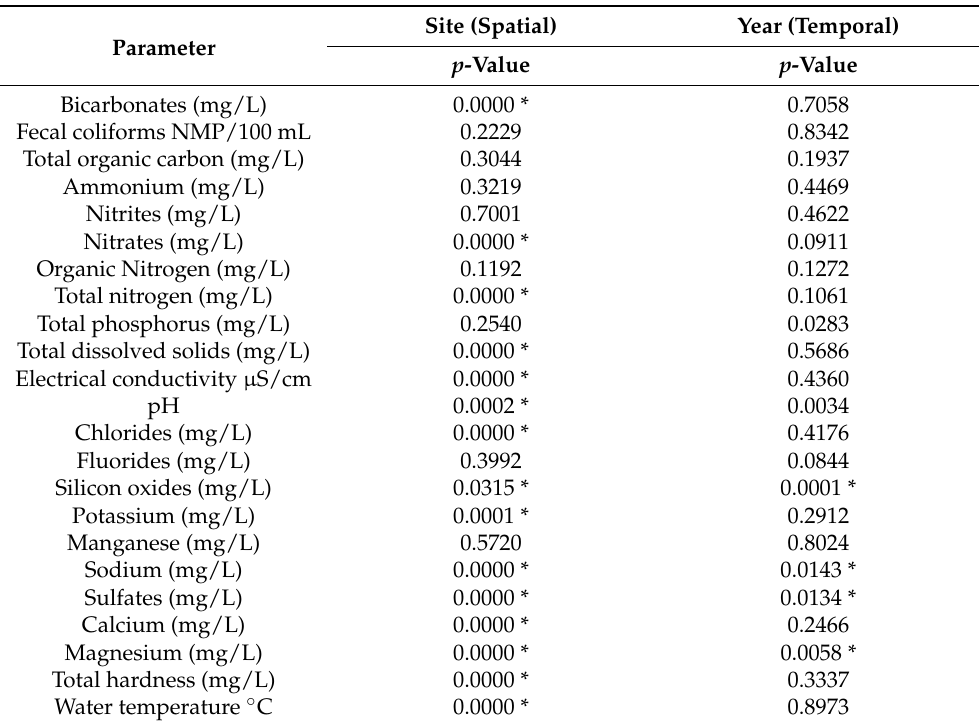
Table 3. Spatial and temporal statistical analysis (ANOVA) of the water quality parameters measured in the Cuernavaca aquifer.